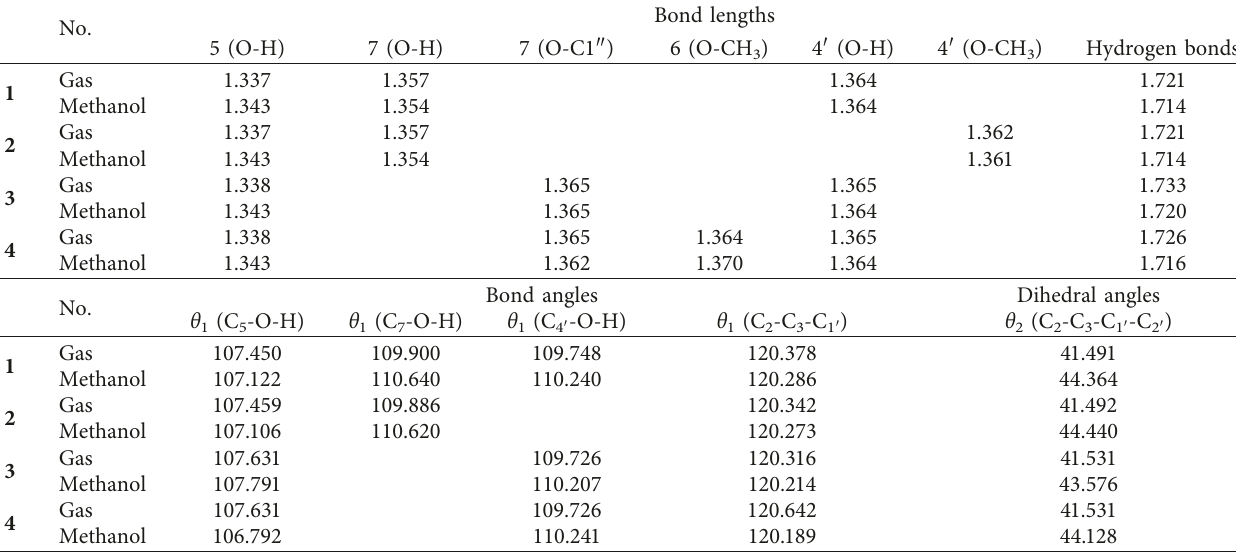
Figure 2: State forms of studied structures 1–4 in gas medium. (a) Compound 1 . (b) Compound 2 . (c) Compound 3 . (d) Compound 4 . Table 1: Optimized bond distances, bond angles ( θ 1 ), and dihedral angles ( θ 2 ) of studied compounds with B3LYP/6-311G(d) in gas and methanol